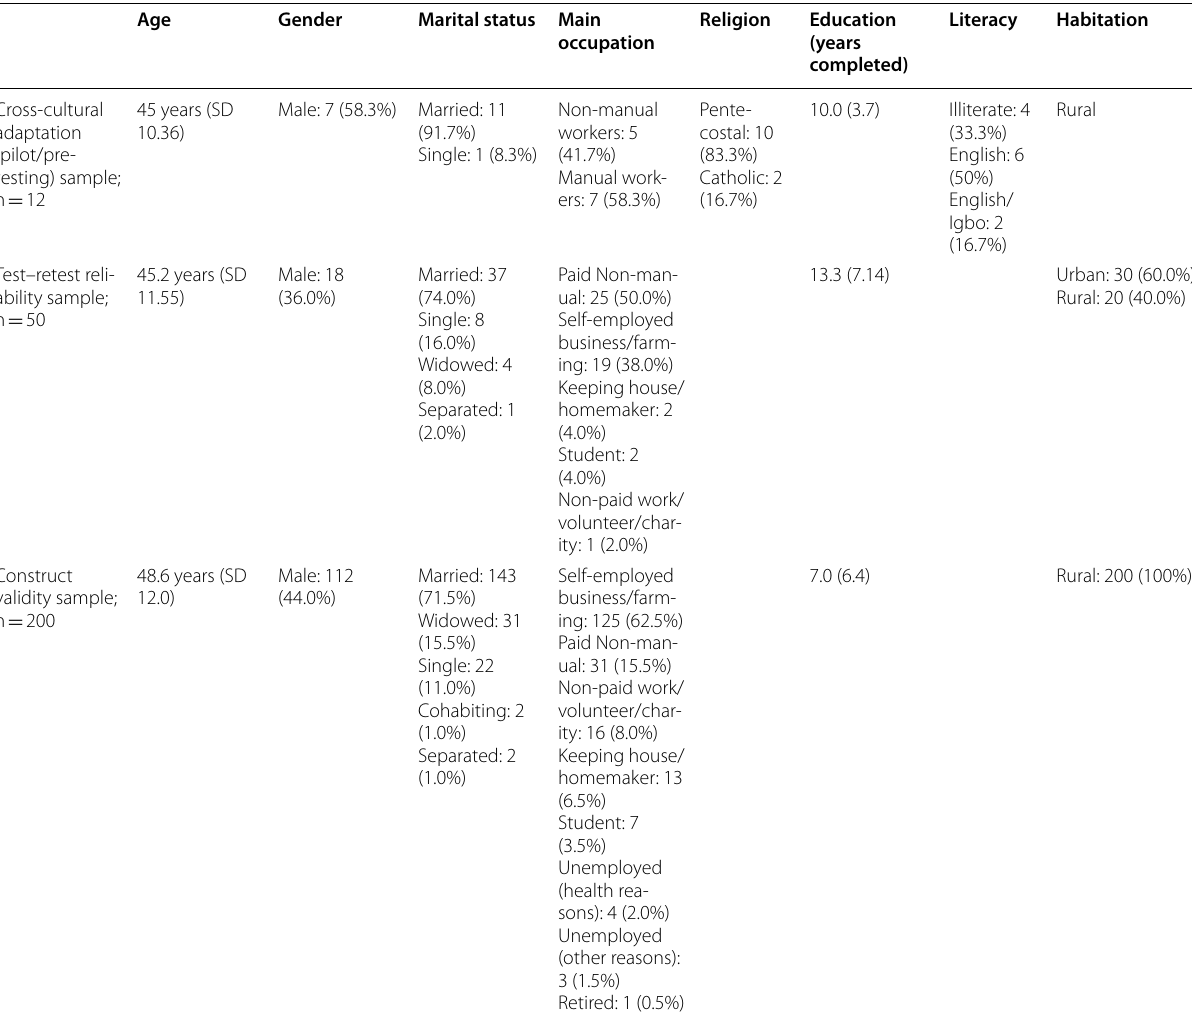
Table 1 Demographic characteristics of participants in the three